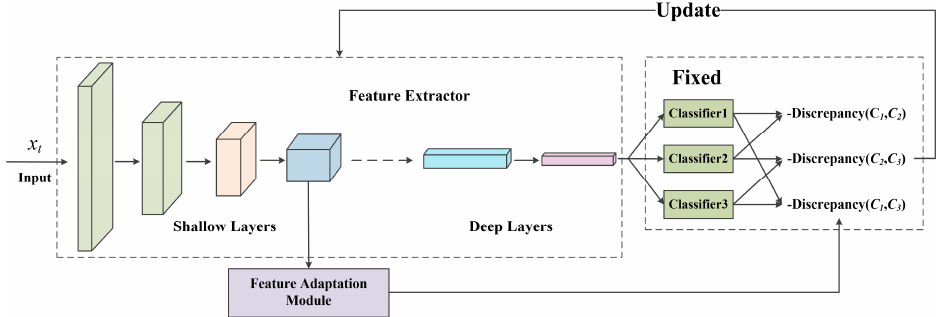
Figure 7. Optimizing the feature extractor. Then, all steps are repeated until the best model parameters are obtained. The entire algorithm of the proposed ECA-FAM structure is listed in Algorithm 1. Algorithm 1. Algorithm for training the ECA-FAM structure.